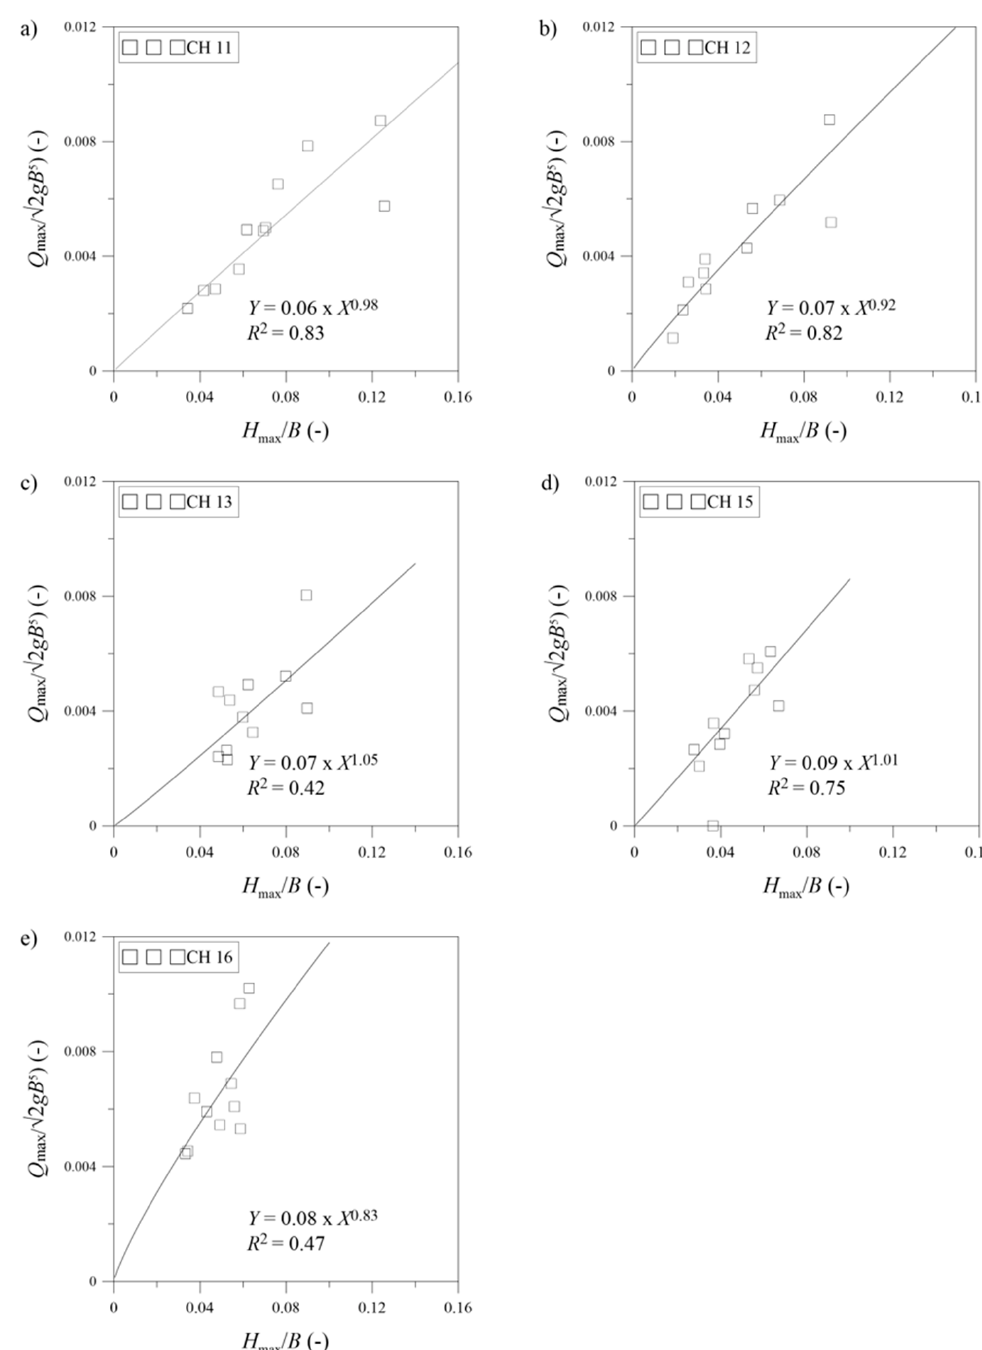
Figure 7. Plot between dimensionless measured maximum overtopping depth and calculated maximum discharge for CH 11, 12, 13, 15, and 16, respectively, for an upstream dam slope of 1 to 1.5 for C d calibration.